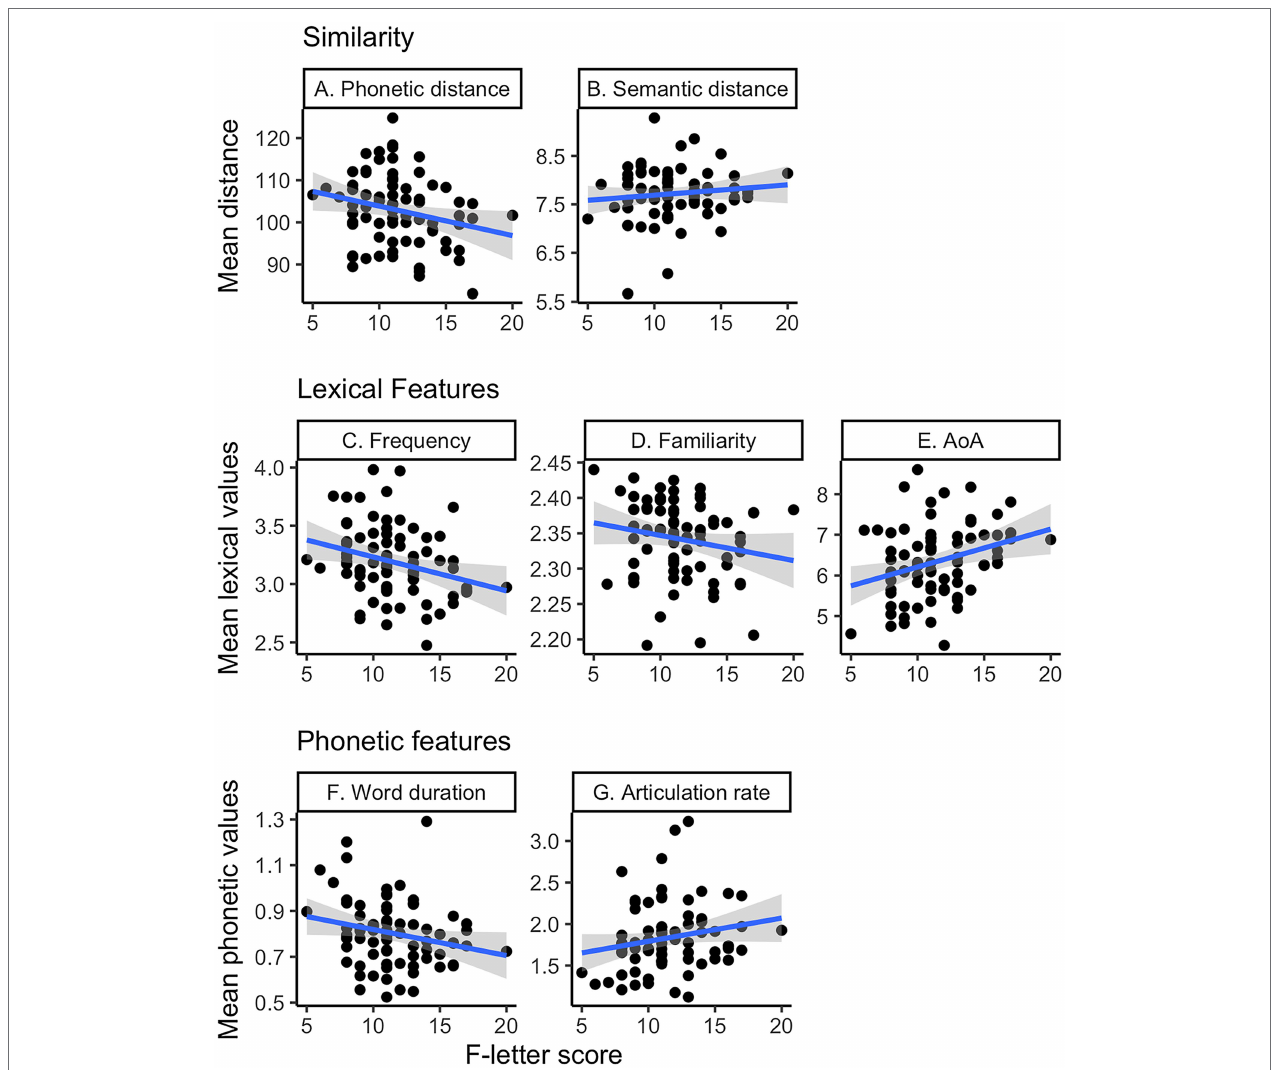
FIGURE 2 | F-letter performance and the mean language measures. The x-axis shows the fluency score in all panels.